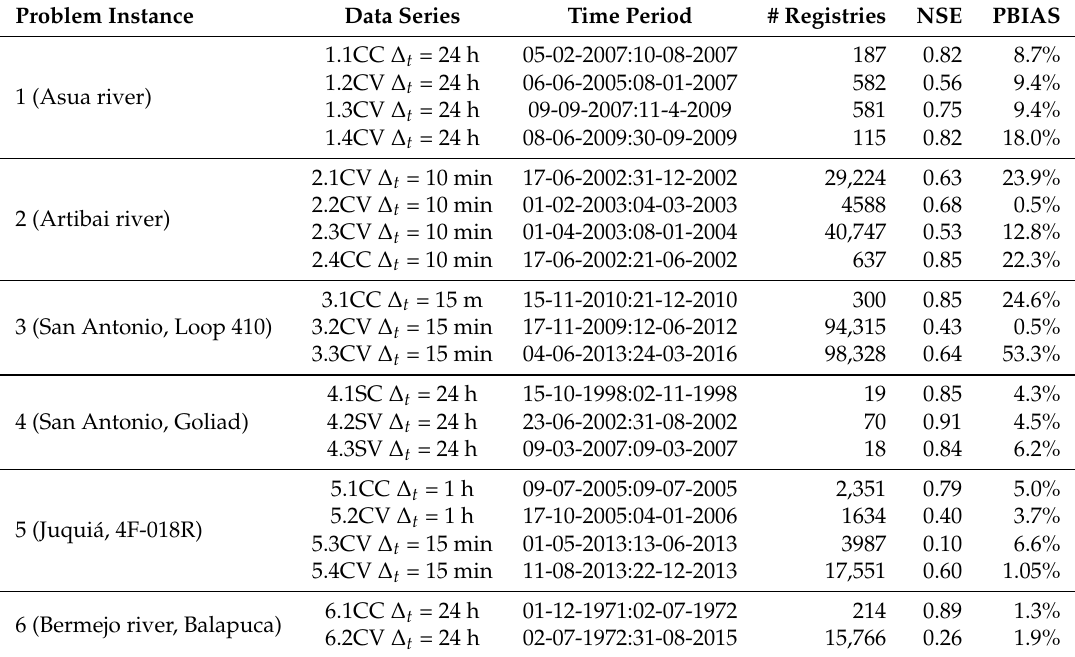
Table 3. Objective values NSE and PBIAS of selected solutions according to each data series, time period, and